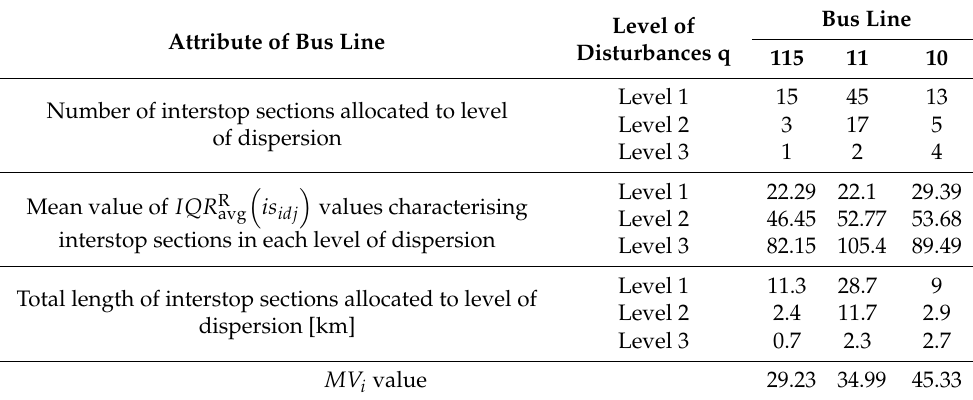
Table 4. Characteristics of the lines in term of IQR R avg